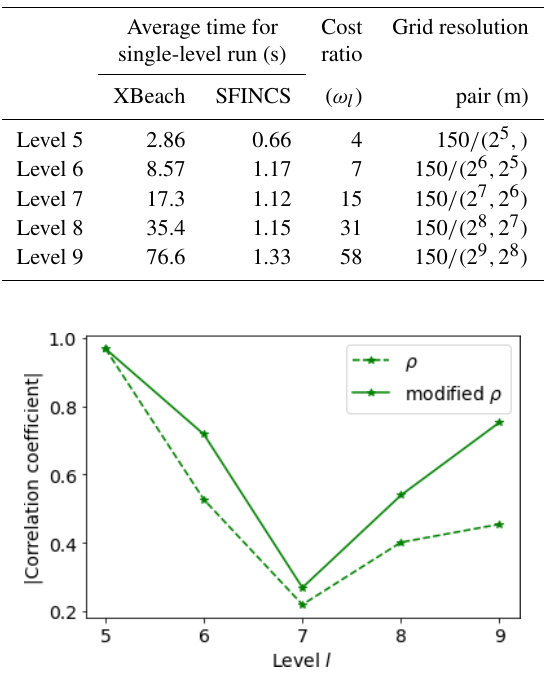
Figure 14. Comparing the real and modified correlation values between SFINCS and XBeach to determine the maximum run-up height in the Carrier–Greenspan test